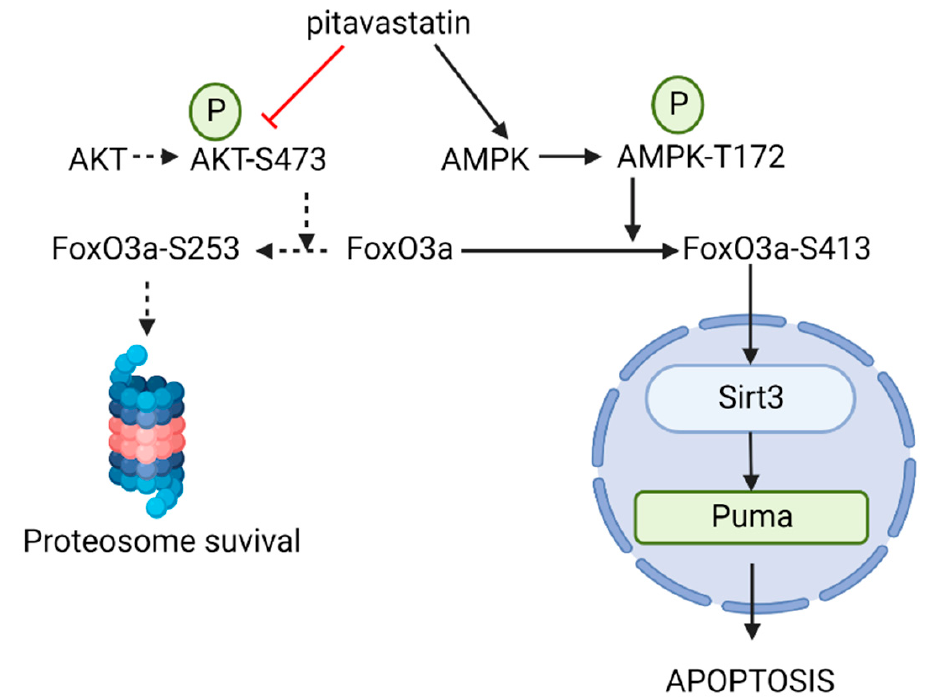
Figure 9. Pitavastatin in B-cell ALL. Pitavastatin treatment leads to increased activation of FoxO3a phosphorylation on S413, leading to Sirt3/Puma-mediated cell death. The AKT-mediated protection pathway was not activated with the treatment of pitavastatin [11]. Drawn using Biorender.